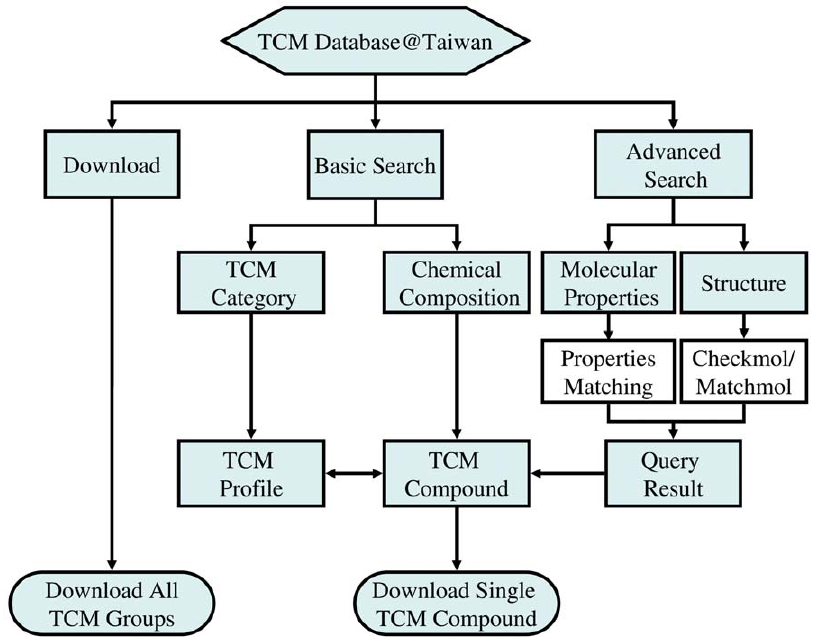
Figure 1. Search flowchart and available download options in TCM database.